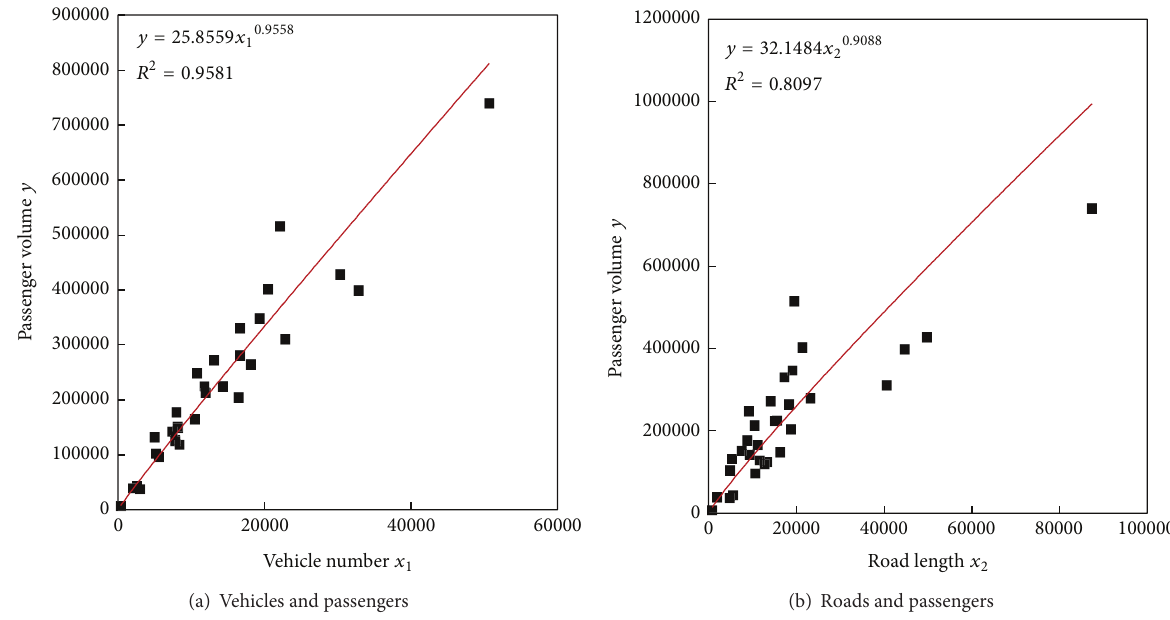
Figure 3: The allometric scaling relations between vehicles/roads and passengers: local modeling of the urban public transportation of China (2012). Table 4: Parameters and main statistics based on allometric scaling for two types of models on public transportation of China’s cities (2012). Global modeling (public transportation) Local modeling (bus and trolley bus) Parameter and statistic 𝑥 𝑦 𝑥 𝑦 𝑥 𝑦 𝑥 𝑦 1 versus 2 versus 1 versus 2 versus Proportionality coefficient 𝑐 18.3409 20.8673 25.8559 32.1484 Scaling exponent 𝑑 0.9972 0.9604 0.9558 0.9088 Determination coefficient 𝑅 2 0.9498 0.8042 0.9581 0.8097 Cross elastic coefficient 𝜎 0.4986 0.4802 0.4779